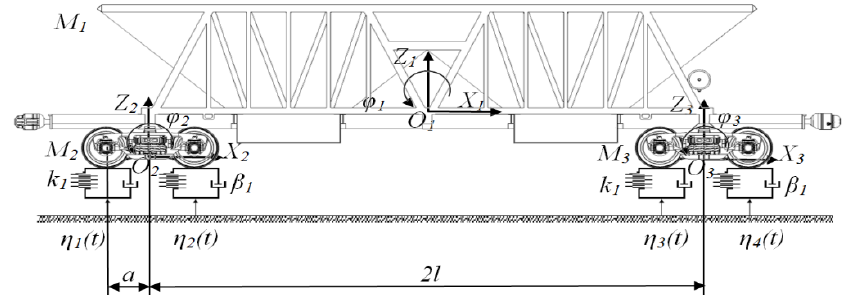
Figure 12. Calculation